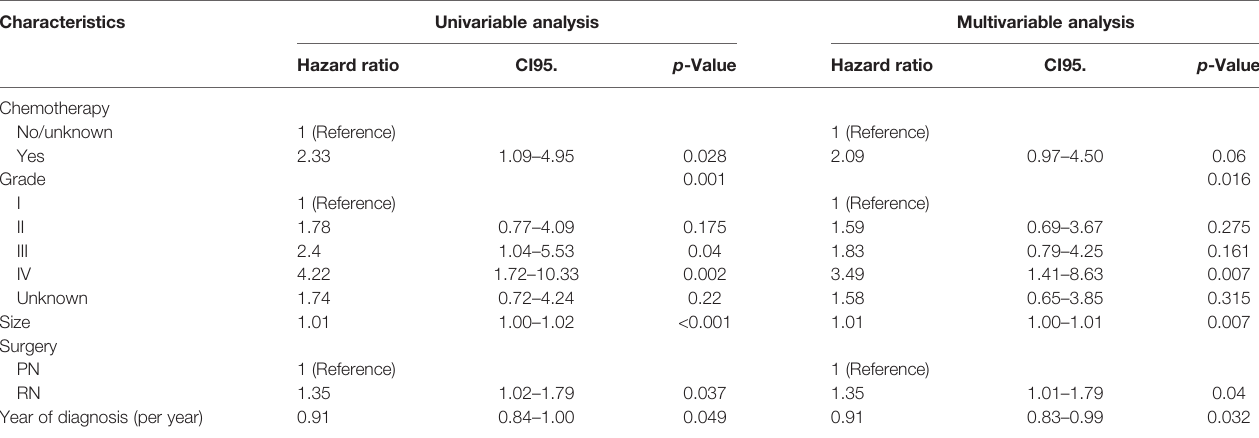
TABLE 4 | Univariate and multivariate analyses of OS in the fat invasion cohort. Characteristics